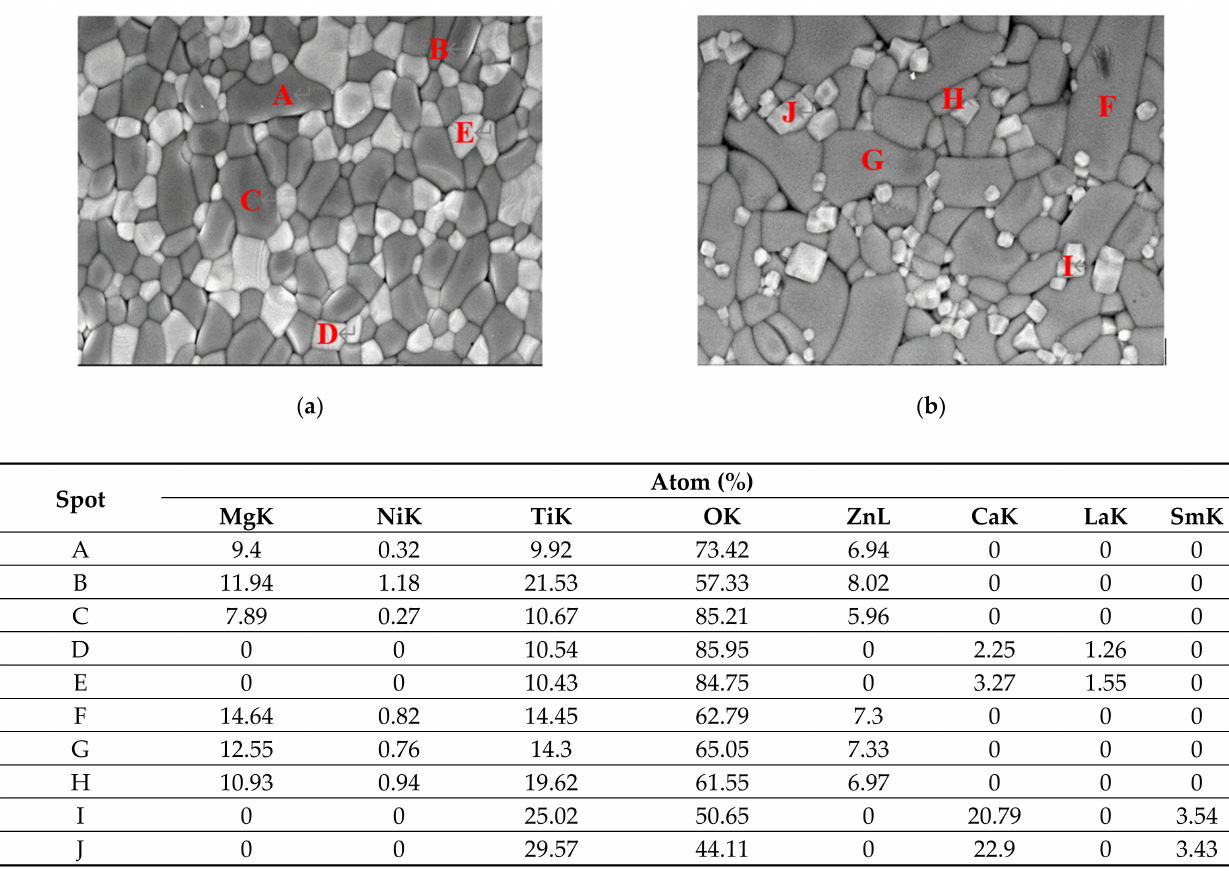
Figure 5. The BEI photograph and EDS results of (Mg 0.6 Zn 0.4 ) 0.95 Ni 0.05 TiO 3 ceramics with ( a ) Ca 0.6 La 0.8/3 TiO 3 sintered